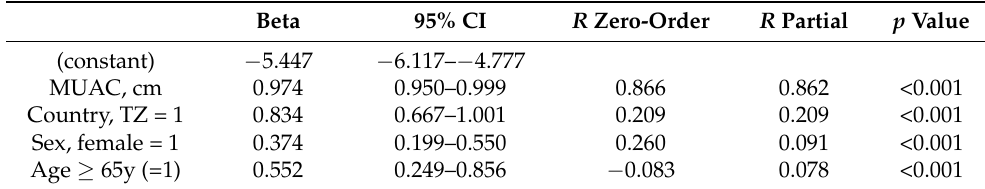
Table 3. Multiple linear regression analyses assessing predictors of BMI [kg/m 2 ]. Beta 95% CI R Zero-Order R Partial p Value